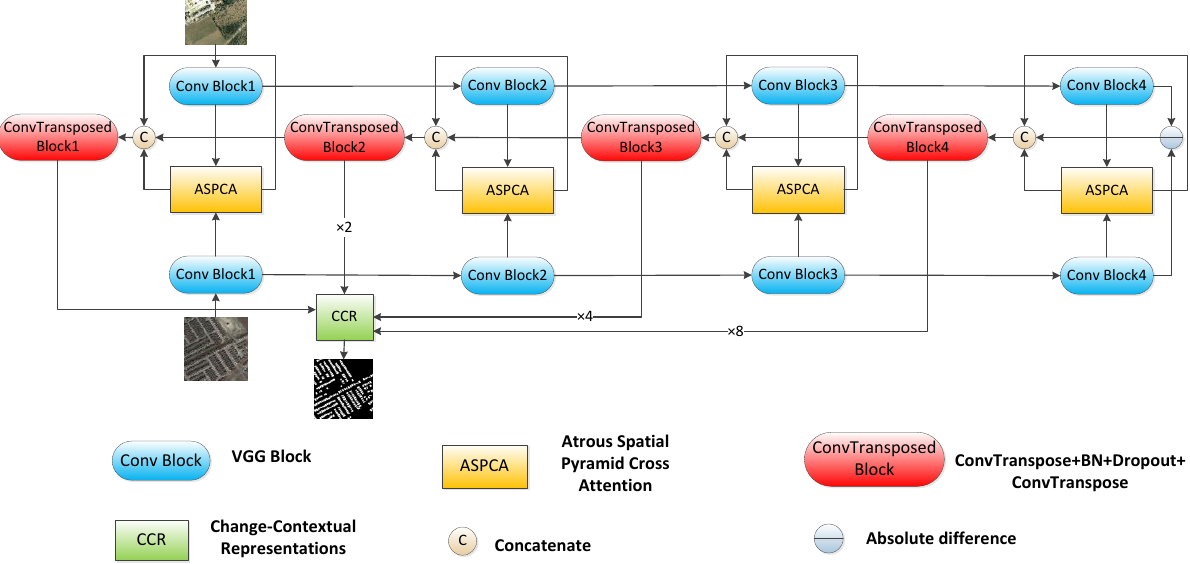
Figure 2. The overall architecture of the multi-level change contextual refinement net (MCCRNet).